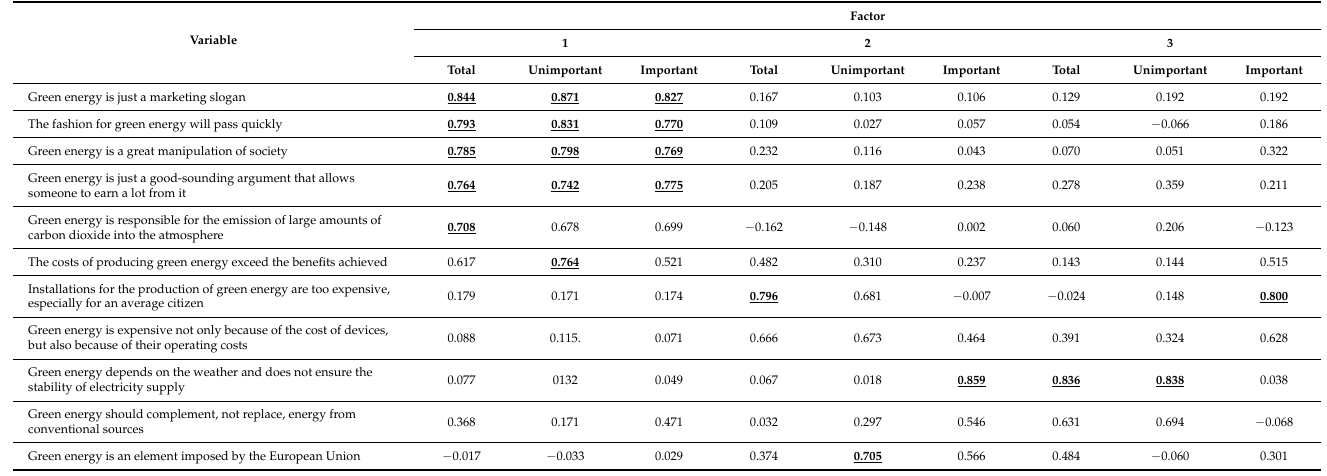
Table 9. Results of the factor analysis of respondents’ associations regarding green energy, reflecting the level of their market awareness, and the importance ascribed to the sources of energy used.